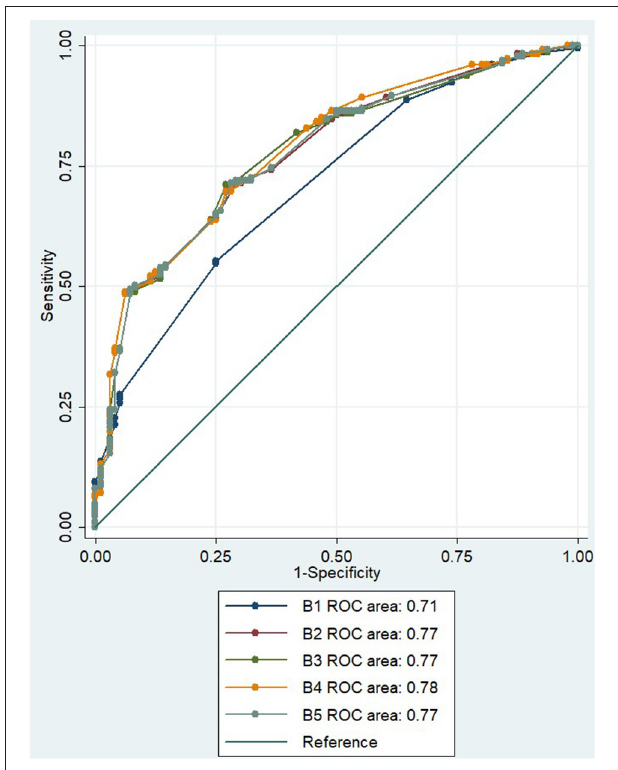
FIGURE 2 | ROC for multiple regression model to distinguish between TIA and mimic. ROC, receiver operator curve; NIHSS, National Institutes of Health Stroke Scale; CTA, computed tomography angiography; CTP, computed tomography perfusion.